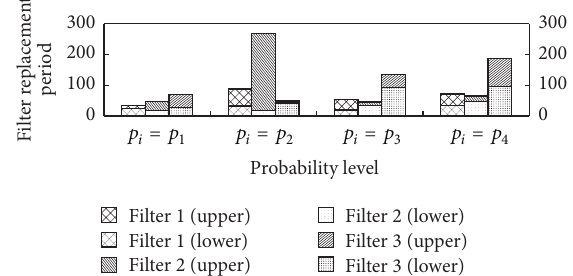
Figure 11: Filter replacement periods for Scenario 7 under high contaminant ingression/generation